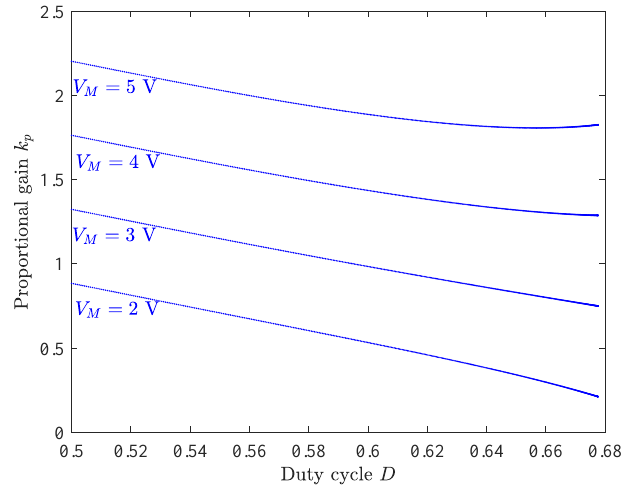
Figure 8. Stability boundaries in terms of the proportional gain k p and the quasi-steady-state duty cycle D for different values of the ramp amplitude V M